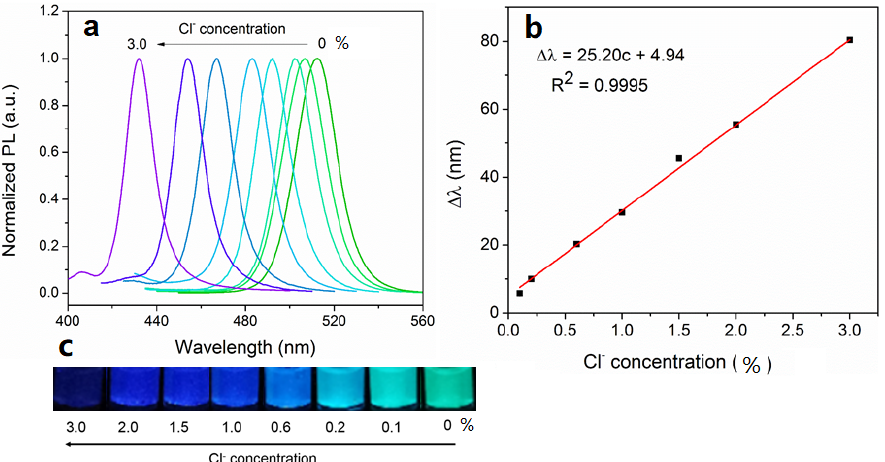
Figure 7. Fluorescence spectra and corresponding fluorescence photographs of the solutions in the presence of different concentrations of chloride from 0–3.0% at 365 nm UV excitation ( a ); working curve of the established fluorescent wavelength shift for the sensing of chloride in the range from 0 to 3.0% ( b ), as well as the corresponding colors for different concentrations of Cl − ( c ). In Figure 7c, it is easy to identify color changes for different concentrations of Cl − .